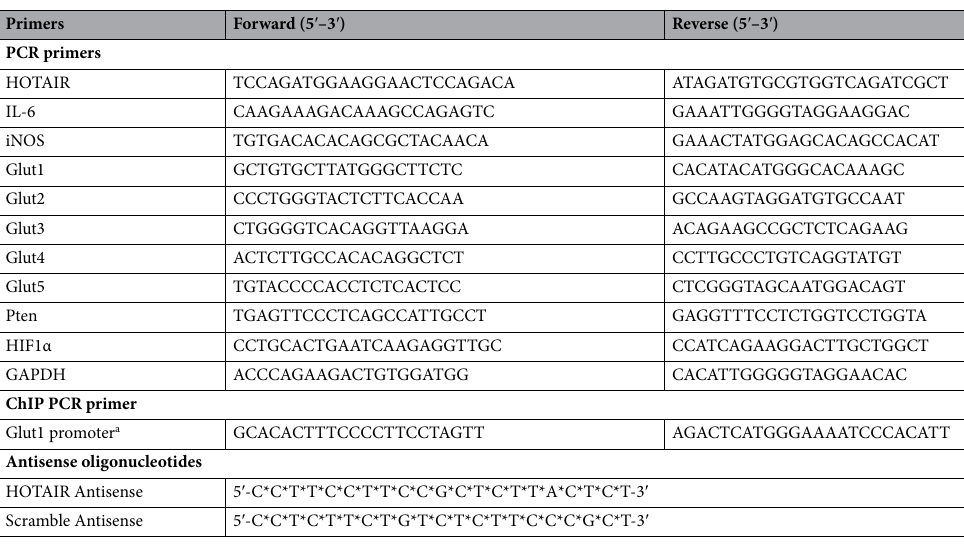
Table 1. Sequences of primers. a ChIP PCR primers are flanked around the NF-κB binding site. *All phosphorothioate linkages instead of regular phosphodiester